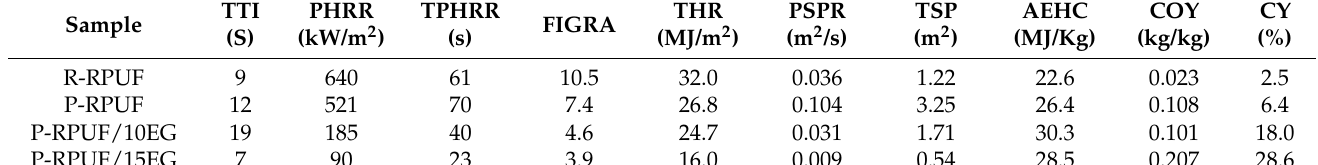
Table 2. Characteristic parameters of CC tests of FPUFs.